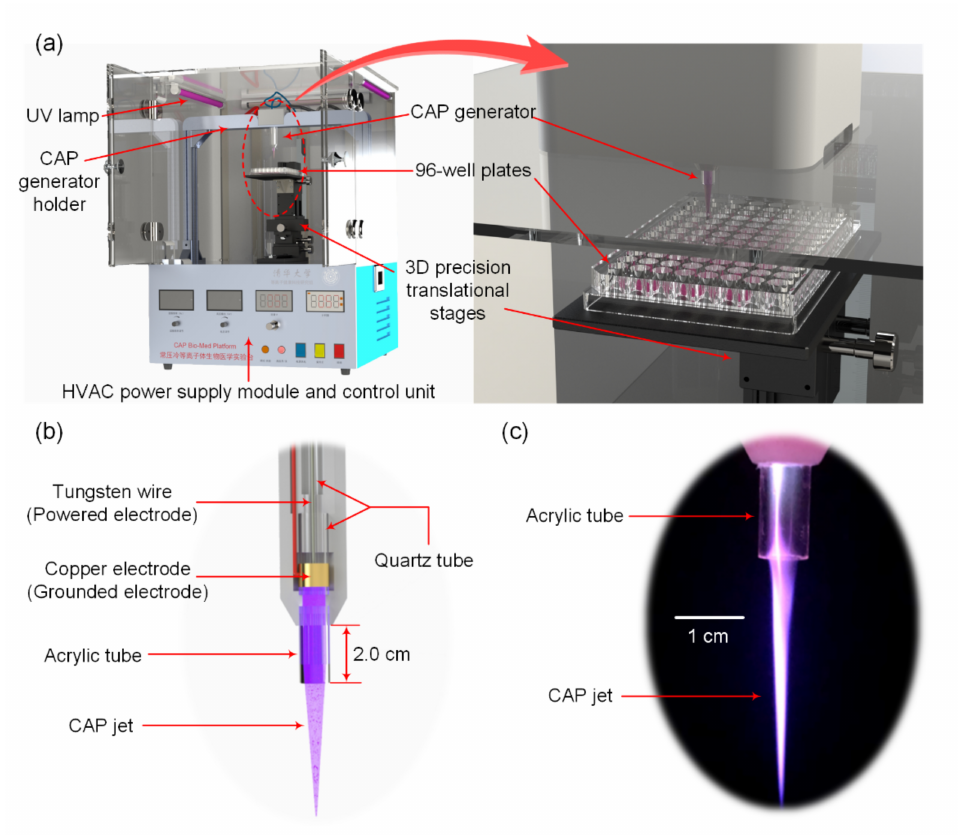
Figure 2. ( a ) Picture of the CAP Bio-Med Platform; ( b ) schematic of the geometrical configuration of the CAP generator; and ( c ) typical image of the CAP